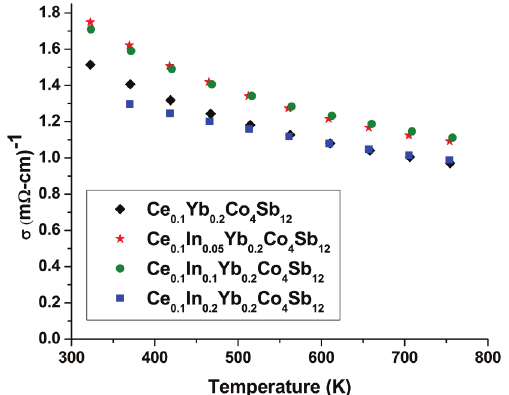
Figure 5. Temperature dependent electrical conductivity of the Ce 0.1 In y Yb 0.2 Co 4 Sb 12 skutterudites showing improvement with small additions of In.